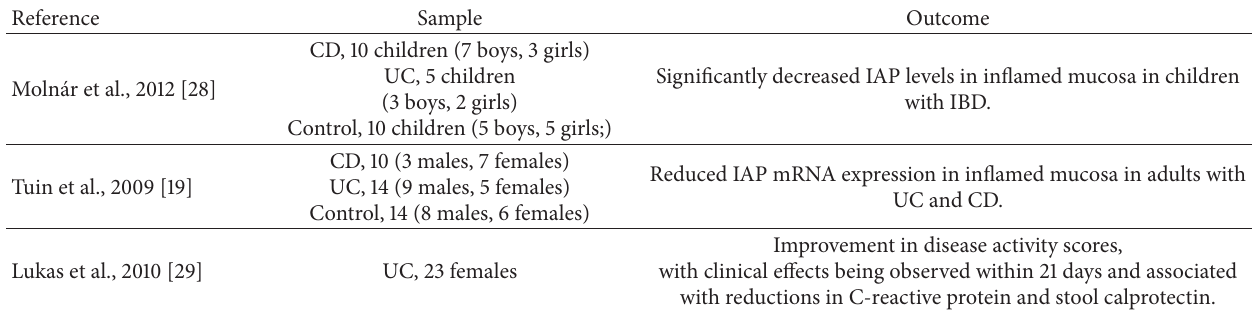
Table 2: Characteristics of studies examining the role of IAP in human